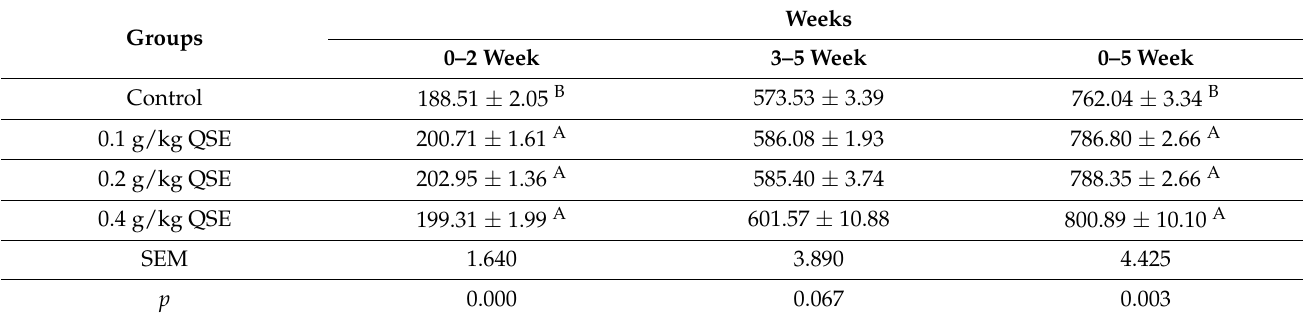
Table 5. Feed consumption of experimental groups (g).